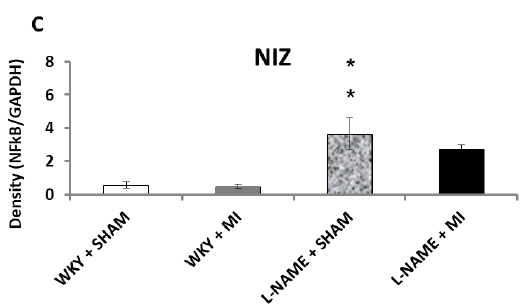
Figure 5. The e ff ect of myocardial infarction on NF ҡ B / p65 expression of infarcted zone (A), injured zone (B) and non-infarcted zone (C) of myocardium. Representative western blot images and relative NF ҡ B / p65 expression levels of sham operated Wistar Kyoto rats (WKY + Sham); WKY rats with experimentally induced myocardial infarction (WKY + MI); sham operated WKY rats treated with L-NAME (20 mg / kg / day) (L-NAME + Sham) and L-NAME (20 mg / kg / day) treated WKY rats with experimentally induced myocardial infarction (L-NAME + MI) in infarcted zone (IZ) (A), injured zone (INZ) (B) and non-infarcted zone (NIZ) (C). ** p < 0.01 compared to WKY + Sham group; # p < 0.05 compared to L-NAME + Sham group; N = 6 in each group.